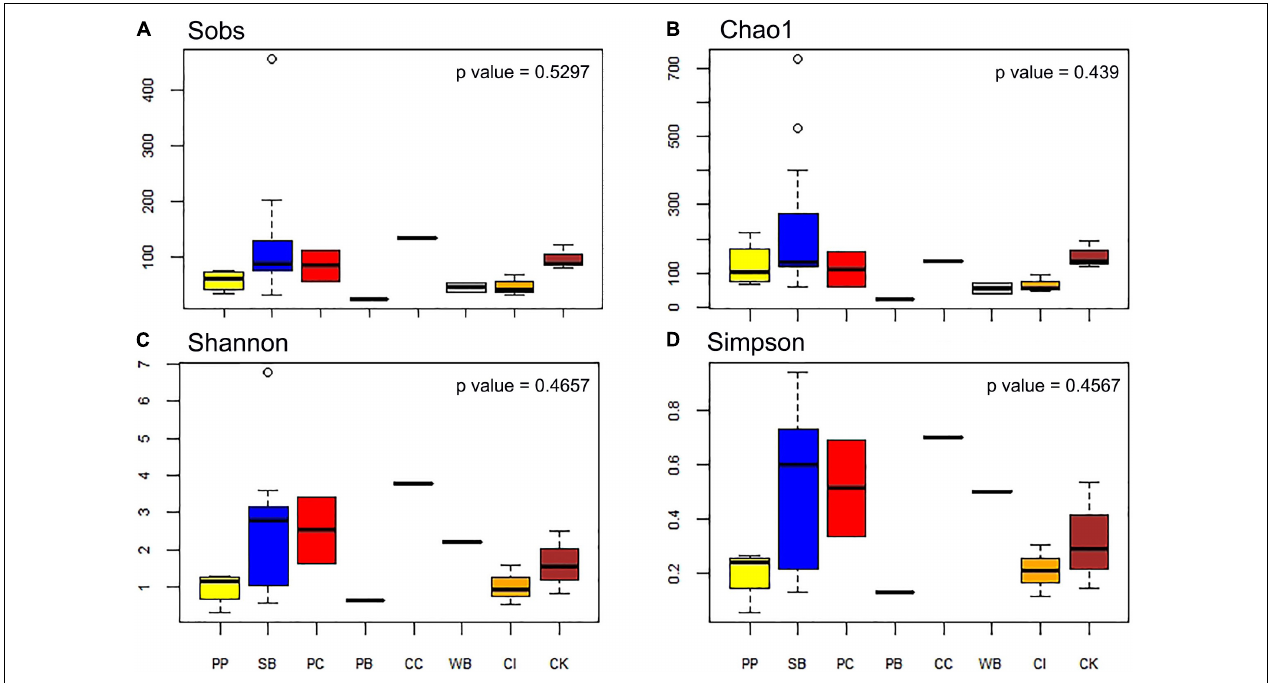
FIGURE 3 | Diversity measures of microbial communities associated with the sponge M. acerata sampled at different sites along the WAP. (A) Observed OTUs, (B) Chao1 diversity index, (C) Shannon diversity index, (D) Simpson diversity index. PC, Potter Cove; CC, Cierva Cove; WB, Wilhelmina Bay; CI, Cuverville Island; PB, Paradise Bay; SB, South Bay; PP, Py Point; CK, Cape Kemp.